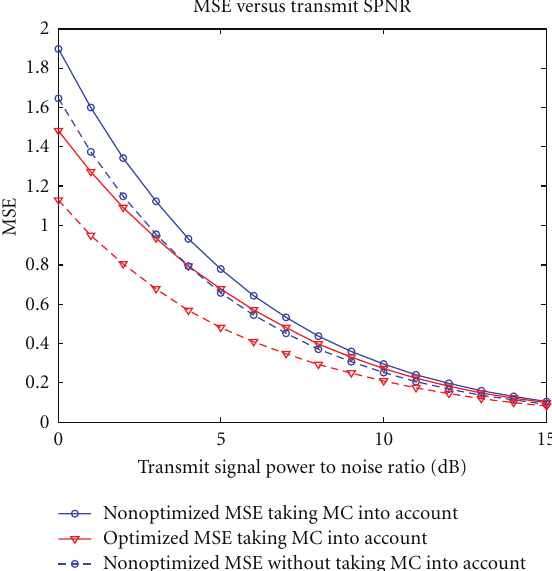
Figure 8: MMSE MSE for versus transmit SPNR with and without taking mutual coupling e ff ects into account for optimized and nonoptimized